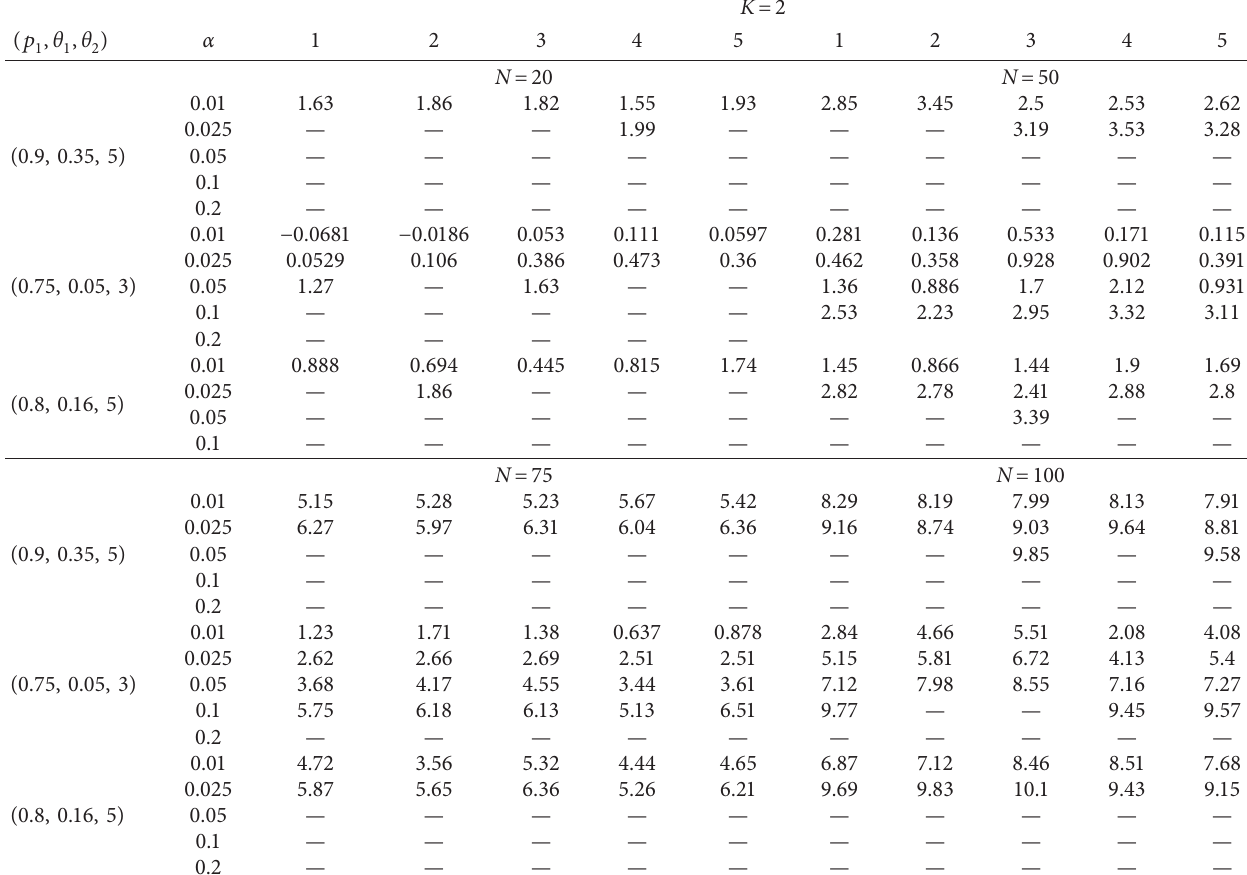
Table 1: Quantiles for estimated number of finite exponential components at k �